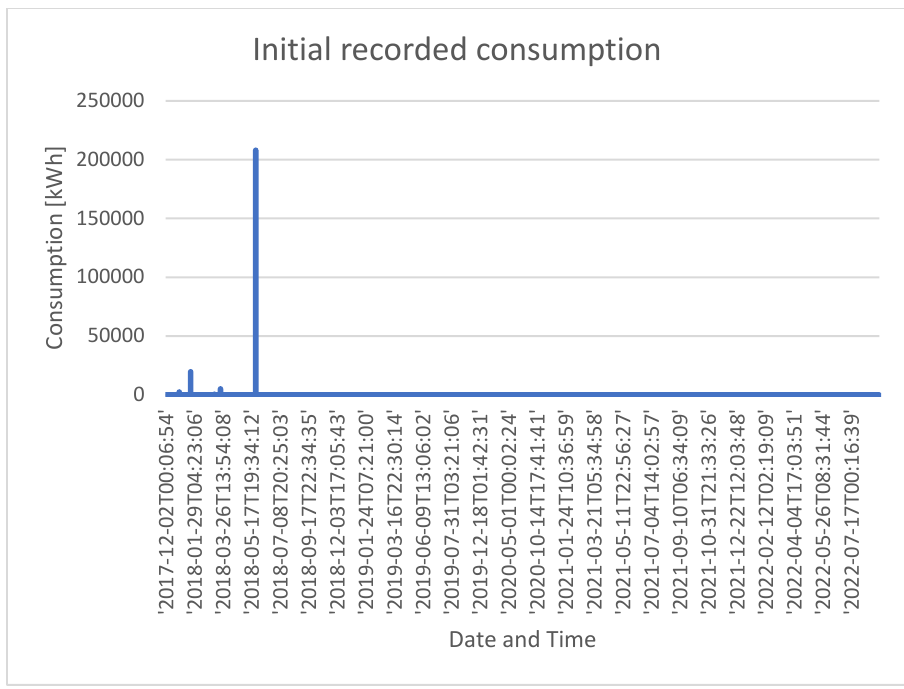
Figure 2. Initial consumption recorded by the BEMS TUCN application at the Faculty of Building Services.